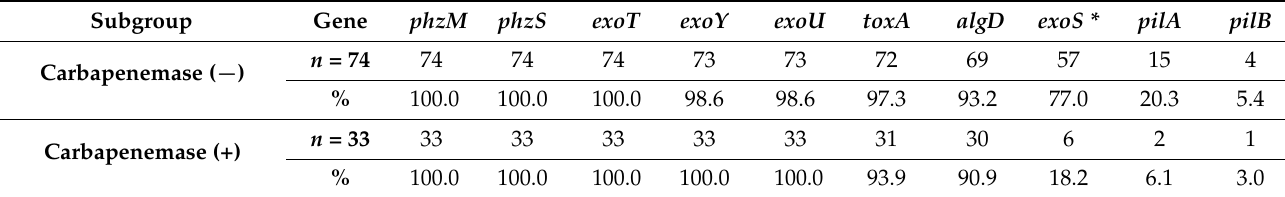
Table 1. The prevalence of the virulence factor genes with respect to the presence of carbapenem resistance mechanisms ( n = 107); (*)—a statistically significant difference ( χ 2 test) noted between the exoS gene frequency in the two strain subgroups is indicated ( p < 0.001).